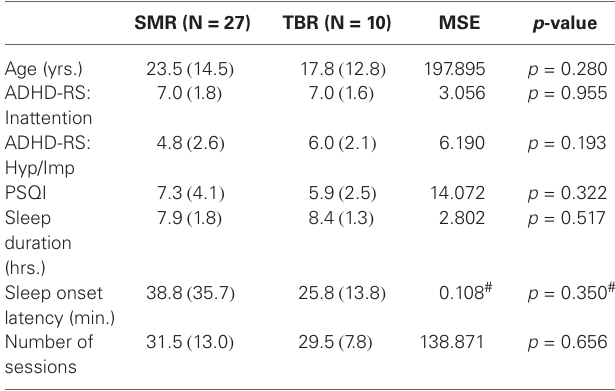
Table 2 | Baseline levels of ADHD and sleep complaints between the SMR neurofeedback treated group and TBR neurofeedback treated group and MSE (mean square error) and p -values